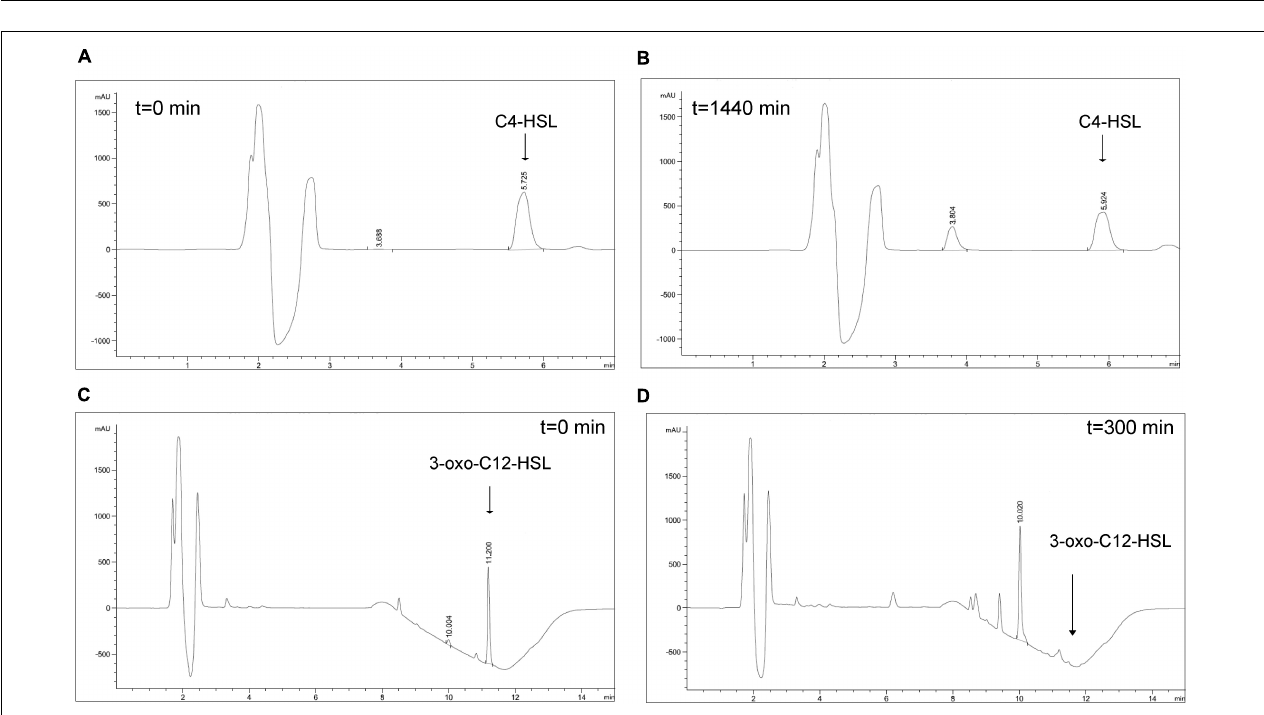
FIGURE 2 | HPLC analysis of AHLs degradation by YtnP-ZP1. Main ion peaks of AHLs standards ( t = 0) (A,C ), as well as ring-opened products of AHLs (B,D) are presented.